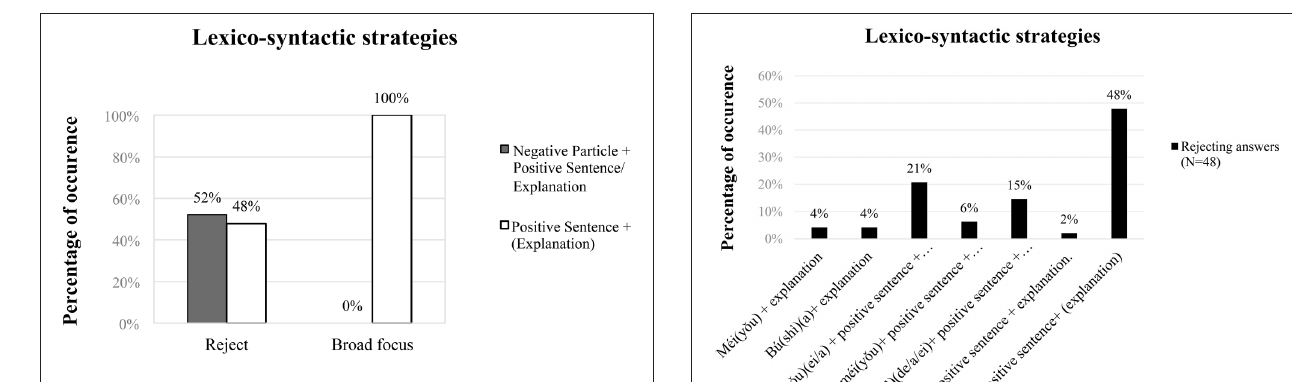
+ explanation (4%), Bú(shì) (a) + explanation (4%), Nˇa lˇı